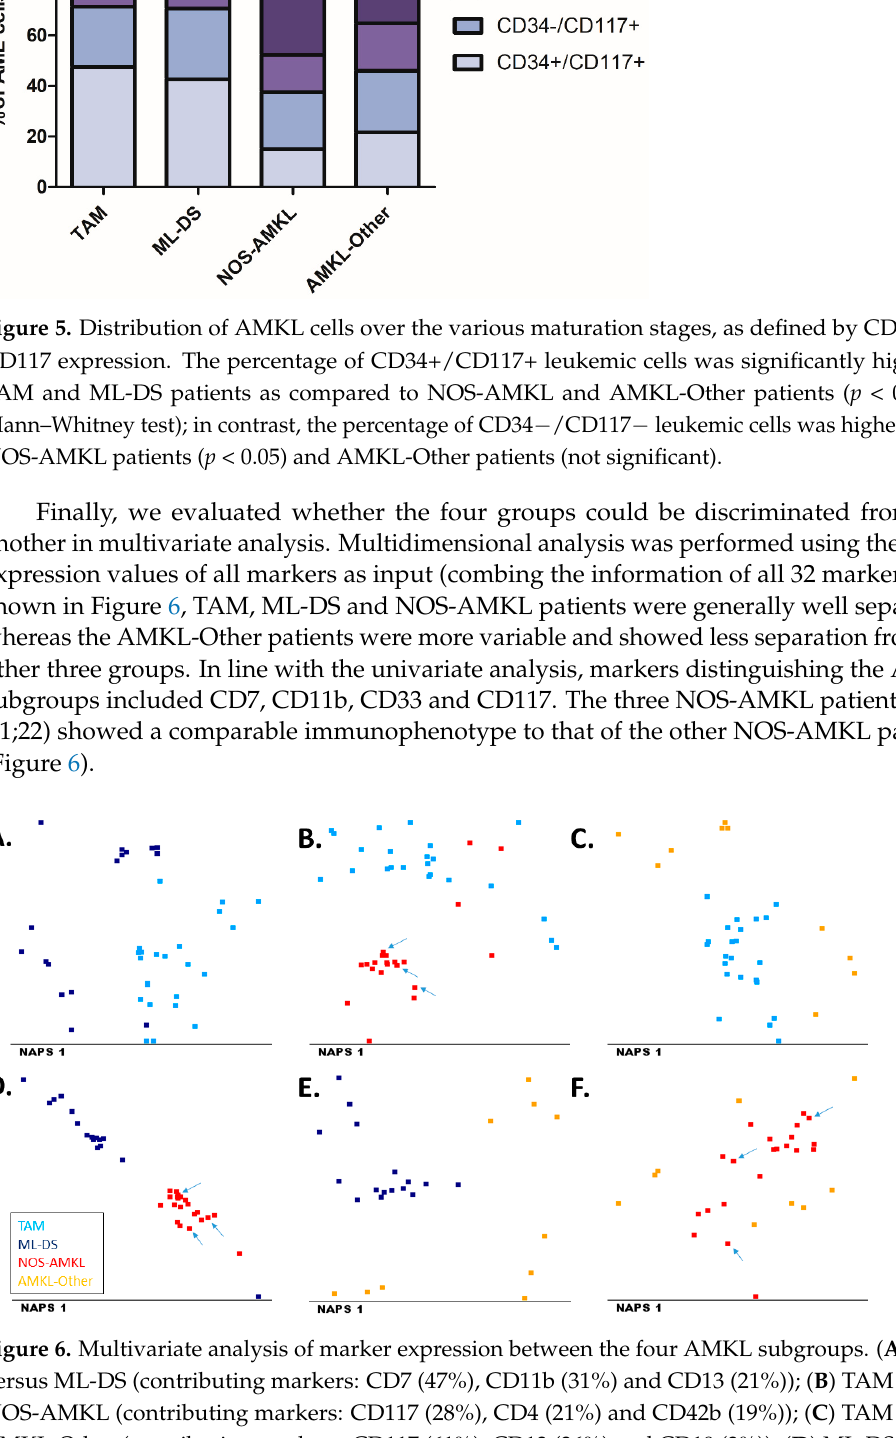
Figure 4. Univariate analysis of marker expression between the four AMKL subgroups. Data repre ‐ sent the MFI values after log10 transformation. The lines the on top of the figures represent statisti ‐ cally significant differences ( p < 0.05) between the two groups. The grey zone indicates MFI levels < 1000; markers with such MFI values were considered to be negative.